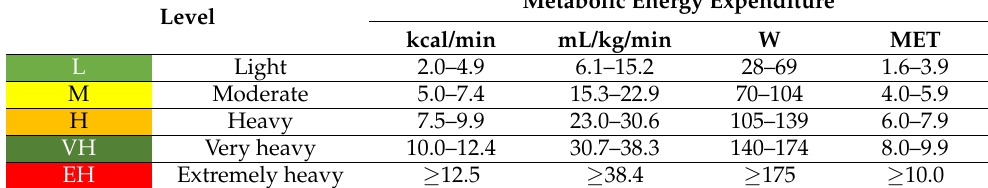
VH EH Extremely heavy ≥ 12.5 ≥ 38.4 ≥ 175 ≥